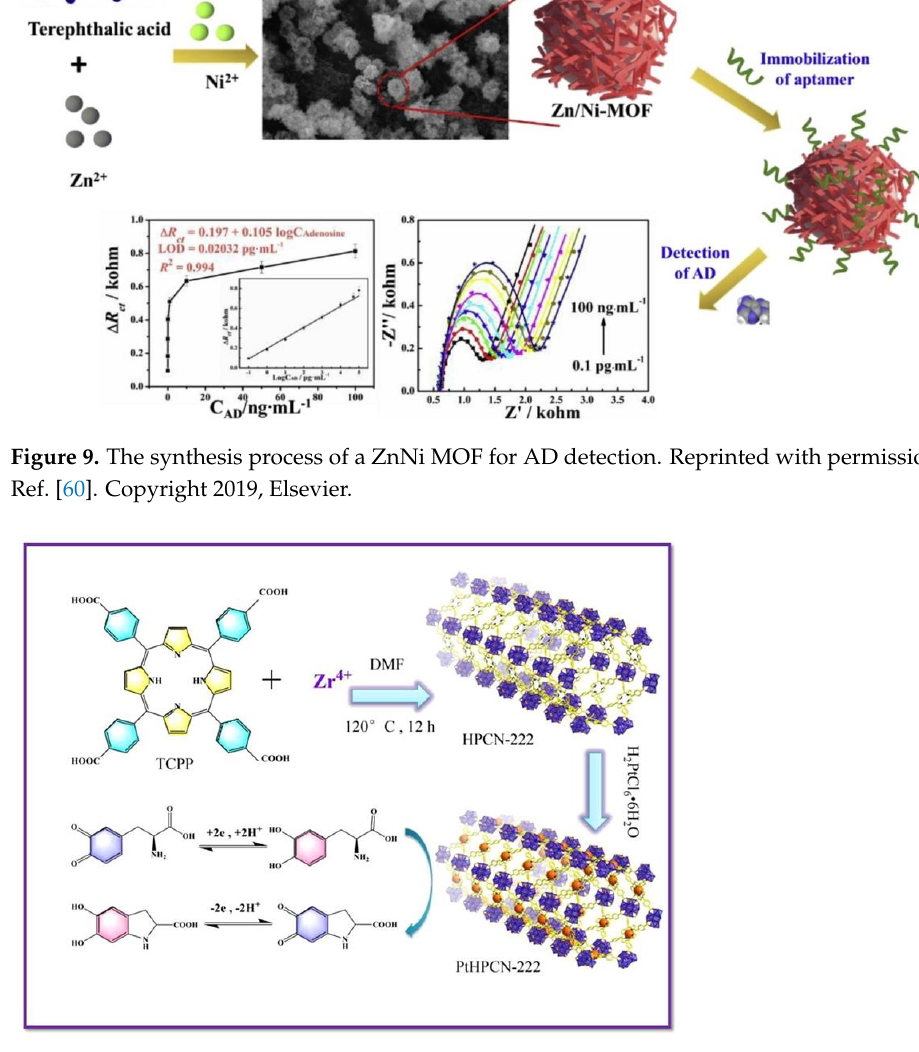
Figure 10. Preparation of PtHPCN – 222. Reprinted with permission from Ref. [61]. Copyright 2022, Elsevier.